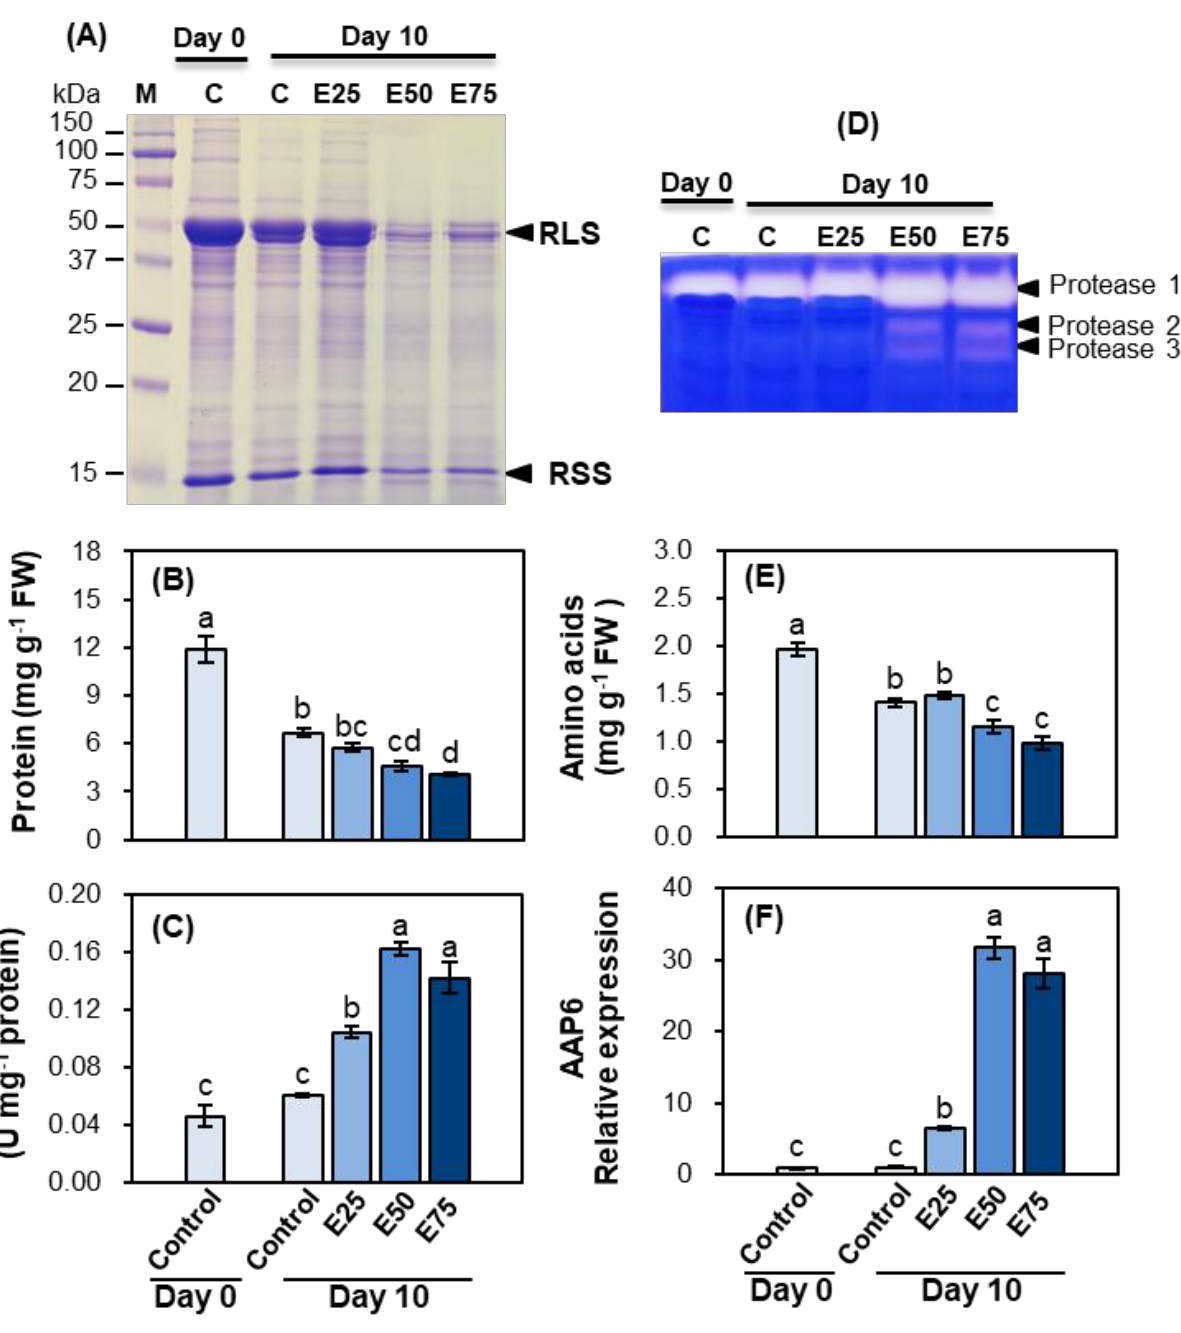
Figure 2. Short – term effects of different concentrations (0, 25, 50, or 75 ppm) of ethephon application on protein degradation and amino acid transport. ( A ) SDS – PAGE protein profiles, ( B ) protein content, ( C ) protease activity, ( D ) protease active staining, ( E ) amino acid content, and ( F ) amino acid transporter (amino acid permease, AAP6 ) gene expression in mature leaves of the control and ethephon – treated plants. Ethephon (0, 25, 50, or 75 ppm) was applied to foliar leaves of Brassica napus for 10 days. E25, E50, and E75 indicate foliar applied ethephon concentrations of 25, 50, and 75 ppm, respectively. Data are presented as mean ± SE (n = 3). The qRT – PCR was performed in duplicate for each of the three independent biological samples. Different letters on columns indicate significant different ( p < 0.05) between treatments.